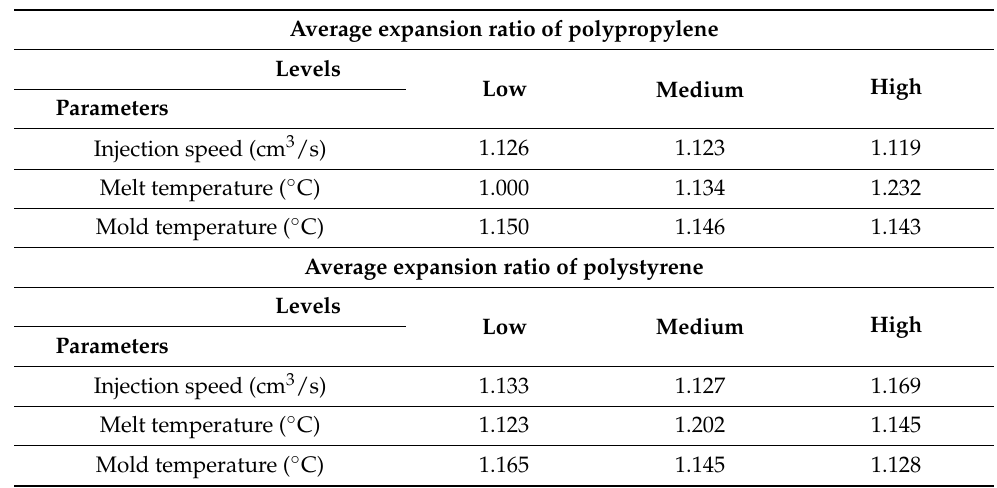
Table 10. Average expansion ratios according to OFAT parameter settings.